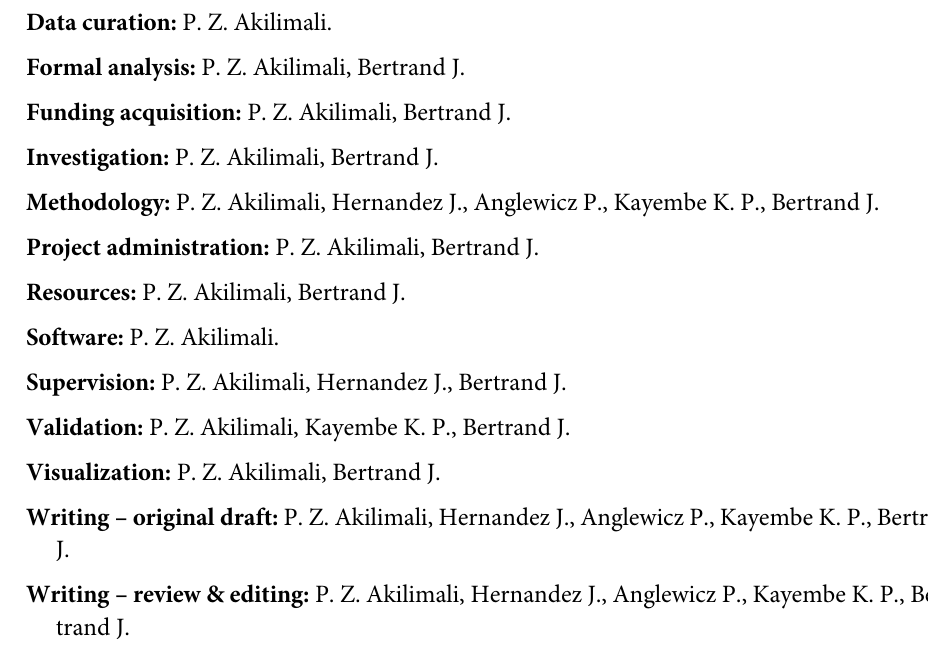
S3 Table. Site where the clients went to remove the